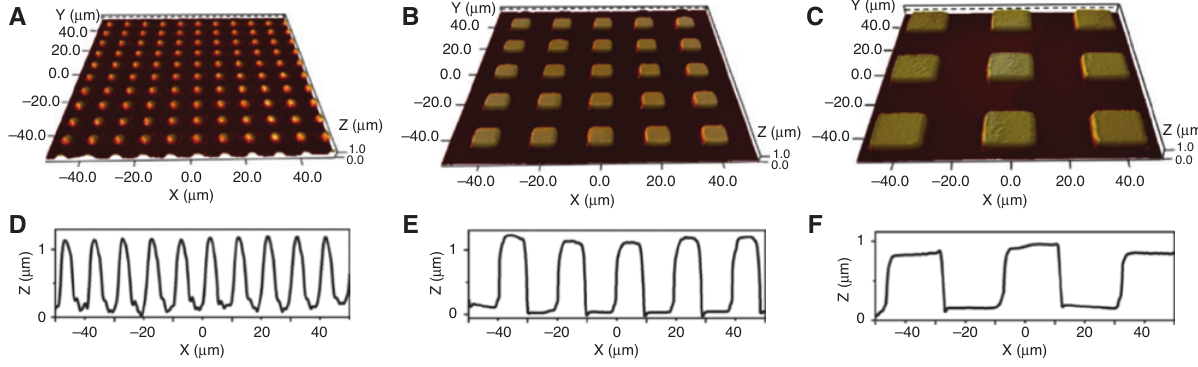
Figure 4: Microscopic performance of the PR gratings with different periods. Comparison between the 3D topographic images of the 2D PR grating fabricated by photolithography using a mask grating with a period of (A) 10 μ m, (B) 20 μ m, and (C) 40 μ m. The corresponding height distribution on the cross-sectional profile is shown in (D–F),